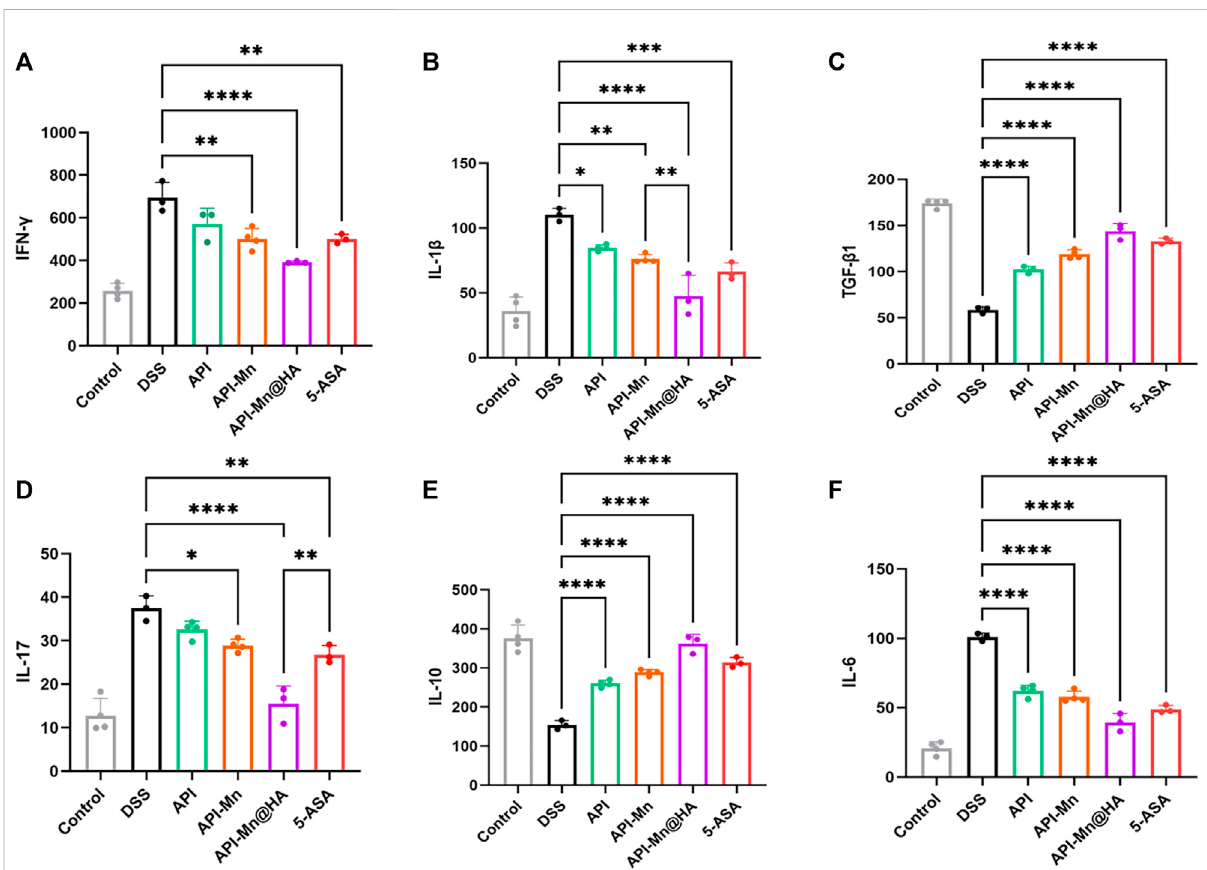
FIGURE 8 Effects of API-Mn(II) complex and API-Mn(II)@HA nanoparticles on the in fl ammatory factors in DSS-induced mice. In fl ammatory factors INF- γ (A) , IL-1 β (B) , TGF- β 1 (C) , IL-17 (D) , and IL-6 (F) were signi fi cantly reduced in the experimental group, while the anti-in fl ammatory factor IL-10 (E) was signi fi cantly increased. Data are shown as mean ± SD. n = 5, * p < 0.05, ** p < 0.01, *** p < 0.001 and **** p <